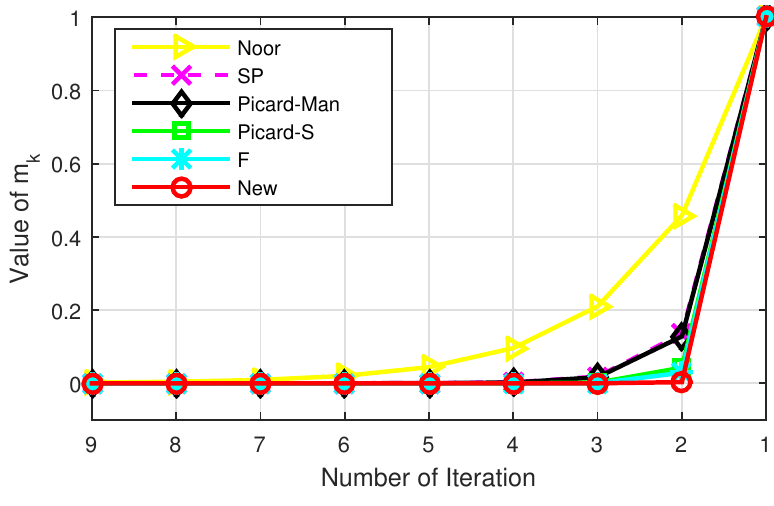
Figure 2. Graph corresponding to Table